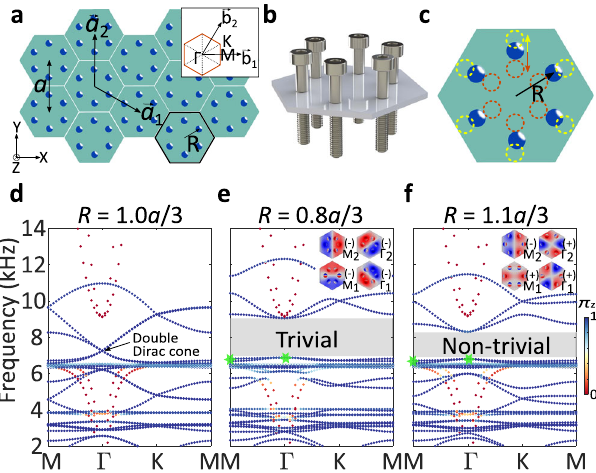
Fig. 1 Unitcell and band structures. a Continuous plate structure with hexagonally arranged bolts (blue dots). The translation vectors ~ a 1 and ~ a 2 and the corresponding reciprocal vectors ~ b and ~ b in the fi rst Brillouin zone 1 2 (inset). b A graphical illustration of the unit cell. c An enlarged plot of the unit cell with expanded ( R > a /3, yellow) and shrunk ( R < a /3, red) arrangements of the mounted bolts. d R = a /3 case, which is exactly the honeycomb lattice with a double Dirac cone at the Γ point. Colorbar represents the level of the out-of-plane motion. e R = 0.8 a /3 case, which leads to the emergence of a trivial band gap represented in gray rectangle. Inset shows the four corresponding eigenmodes extracted from the marked green stars at the M and Γ points. f R = 1.1 a /3 case with a non-trivial band